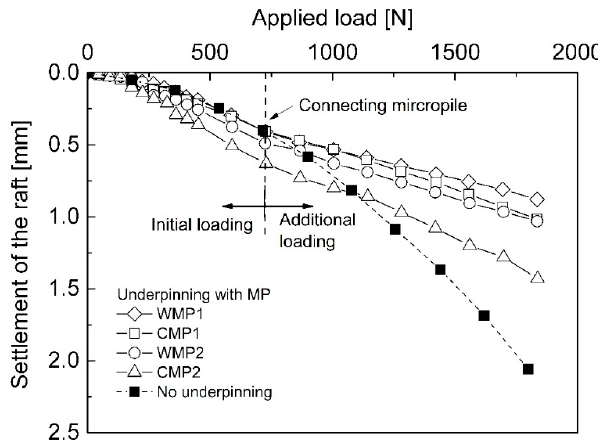
Figure 6. Comparison of load settlement behavior on the raft during initial loading and additional loading on the underpinned foundation.